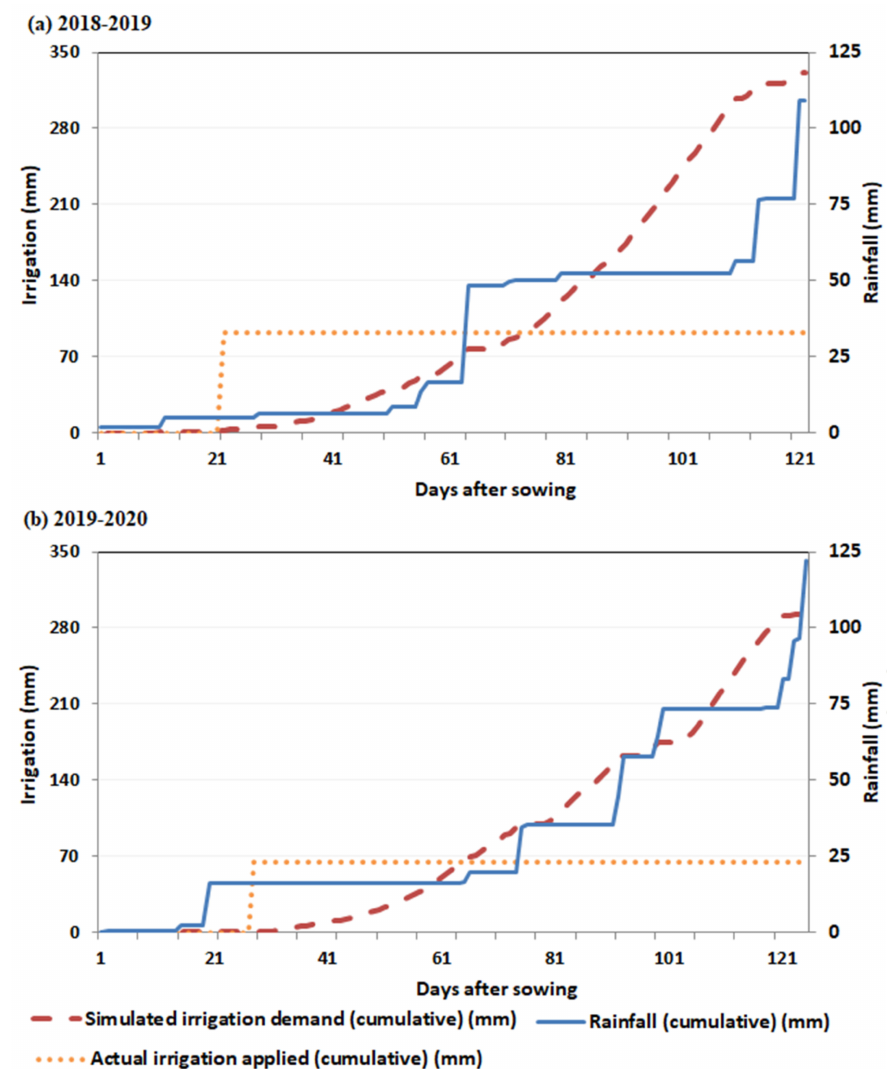
Figure 7. Simulated irrigation required to reach potential yields (red dashed line) compared with actual irrigation (orange dashed line) applied to wheat crop in the Sunsari Morang Irrigation